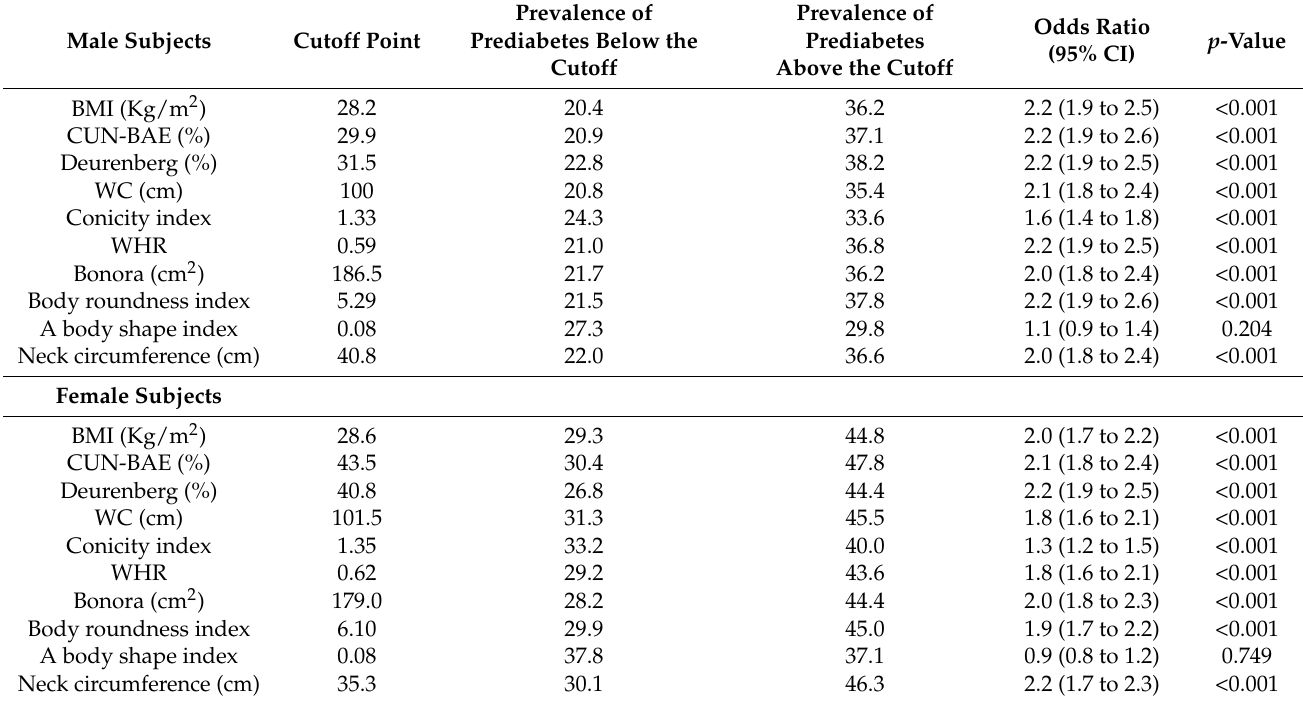
Table 5. Prevalence of prediabetes above and below the cutoff proposed for each anthropometric index.